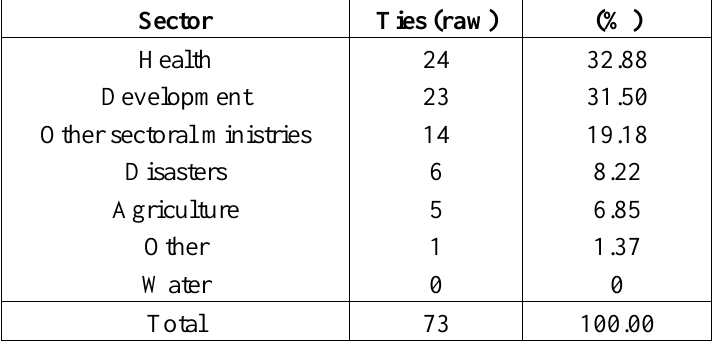
Table 3. Climate change and health-related partnership ties by